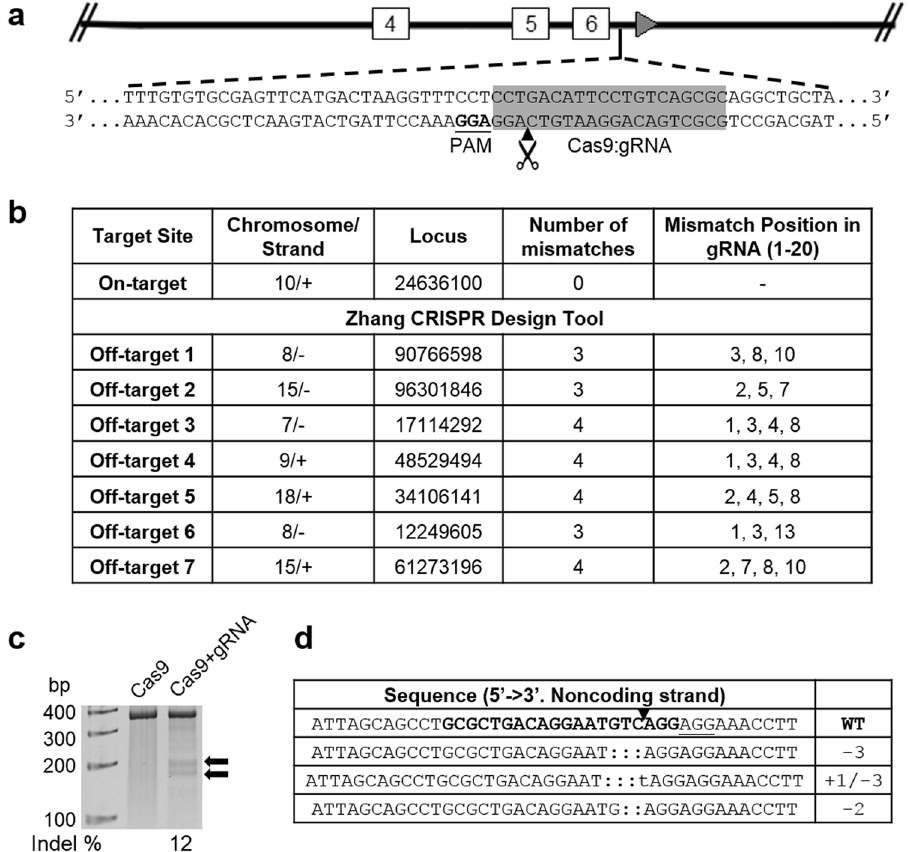
Figure 2. CRISPR/Cas9-mediated gene targeting in mouse iPSCs. ( a ) Schematic diagram showing the site of Arg1 gene modification using CRISPR/Cas9. The gRNA was designed to target a 20 nt region in intron 6 of Arg1 . ( b ) Cas9:gRNA off-target analysis. A table showing the output from CRISPR design tool. The on-site target is given at the top, followed by off-target sequences organized in decreasing Cas9-cleavage probability. ( c ) Detection of Cas9:gRNA-mediated on-target cleavage of Arg1 by the Surveyor nuclease assay. The cleavage products were shown as extra bands (149 bp + 197 bp) indicated by the arrows. Mutation frequency (indel) was calculated by measuring the band intensities. ( d ) Sequencing data from TOPO-cloned PCR amplicons of CRISPR/Cas9-modified genomic DNA showing a few examples of NHEJ-mediated indel mutations at the desired location. gRNA target site is in bold. Deletions are shown in dashes. Nucleotide substitution is shown in lowercase. The net change in length caused by each indel mutation is to the right of each CRISPR/Cas9-mediated reincorporation of deleted exons via homology-directed repair. An optimal gRNA target candidate was chosen based on the highest scoring for on-target and sequence conserva- tion with minimal potential off-target effects using an in silico prediction tool. This gRNA was designed de novo to target intron 6 of the Arg1 locus for the reincorporation of exons 7 and 8 (Fig. 2a). By in silico analysis, we found seven hypothetical off-target sites for this gRNA, which all had at least three mismatched bases (Fig. 2b). Hsu et al . 26 demonstrated that Cas9 showed no measurable cleavage in targets that had greater than two mis- matches, independent of their location within the genome. Surveyor nuclease cleavage at the mismatches pro- duced products of 149 bp and 197 bp (Fig. 2c). This heteroduplex assay determined the ability of gRNA-guided Cas9 to induce DSBs in a precise and predictable manner, with mutation frequencies up to 12% in mouse iPSCs. Sequencing results confirmed cleavage in the target region as evidenced by the presence of NHEJ-induced indels (Fig. 2d). Once measurable cutting efficiency was achieved, we performed HDR by introducing a donor targeting vector together with Cas9:gRNA into Arg1-deficient mouse iPSCs via electroporation. The targeting vector consists of exons 7 and 8 cDNA fused to an RFP monomeric-encoding segment with piggyBac inverted terminal repeats (ITR) flanking a PGK - puro - tk cassette along with two flanking homology arms of the target region to facilitate homologous recombination (Fig. 3a). An HDR stimulatory compound, L-755,507 was added to enhance CRISPR/ Cas9-mediated HDR efficiency 27 . Puromycin-resistant mouse iPSC colonies obtained after electroporation were screened for proper targeting by PCR (Fig. 3b) and genotype confirmed by sequencing (data not shown). 5/23 iPSC clones were identified as targeted with no random integration, 10/23 were targeted correctly only on one arm and 8/23 were non-targeted. Two correctly targeted clones (clones #C2 and #C15) were chosen for subse- quent piggyBac excision experiments. piggyBac transposase electroporation, followed by ganciclovir selection